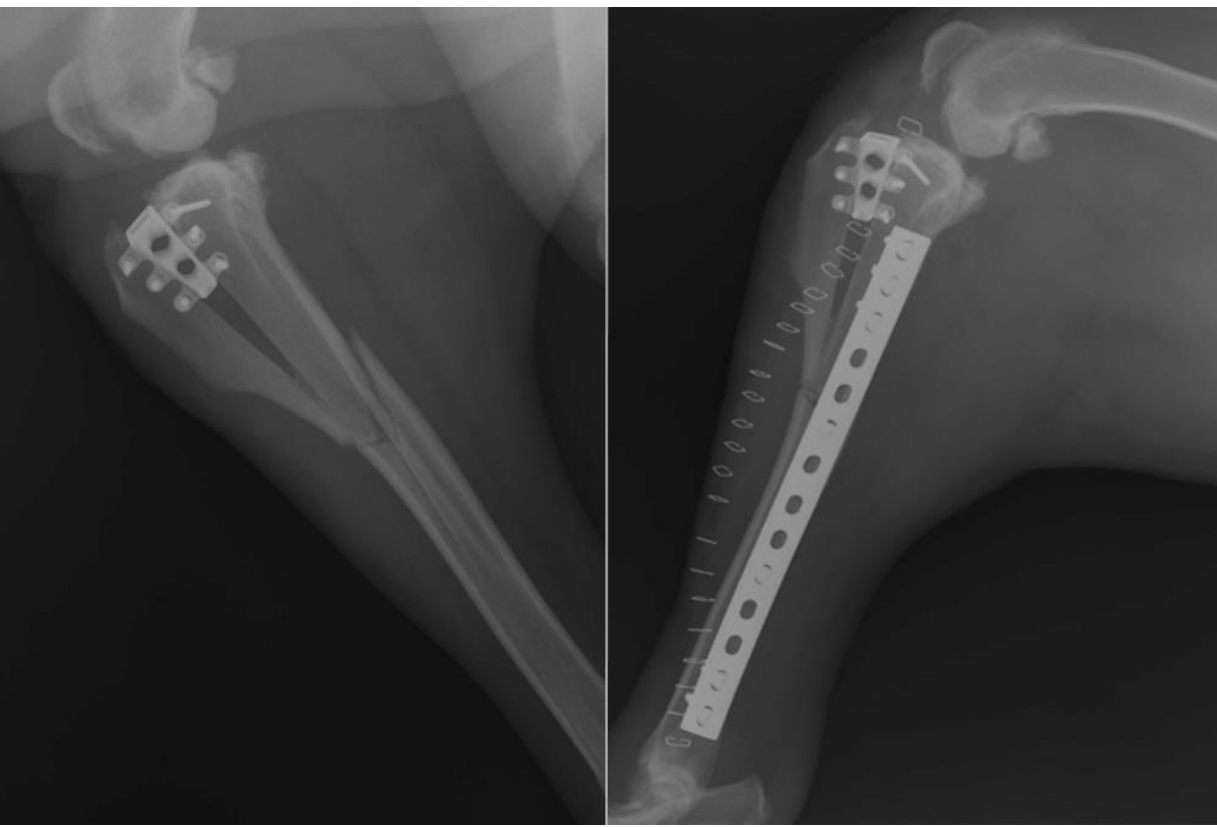
Figure 1: Example of tibial diaphyseal fracture as a complication of TTAR